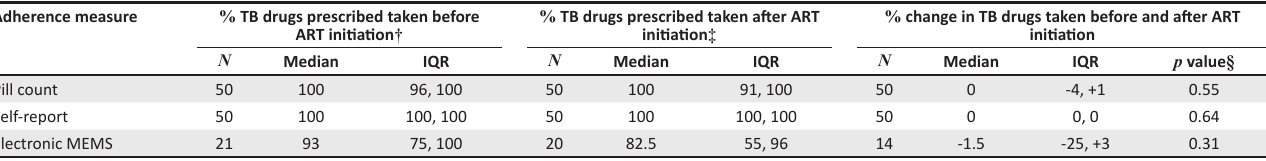
TABLE 2a: Adherence to tuberculosis treatment before and after initiation of antiretroviral treatment. Adherence measure